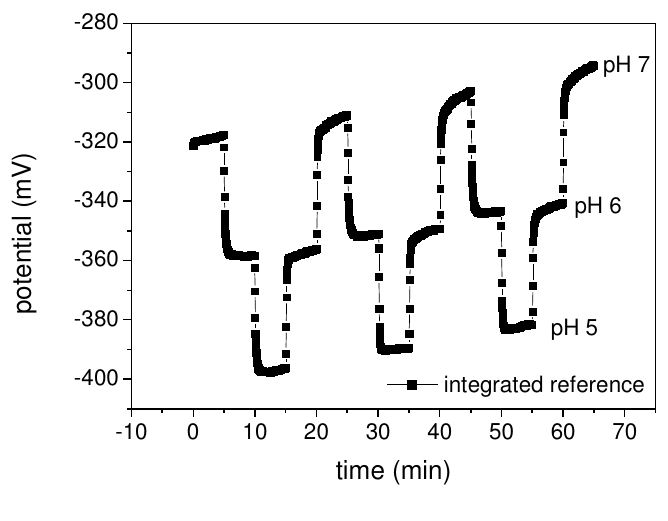
Figure 8. Concap measurement of the system pH sensor/integrated reference